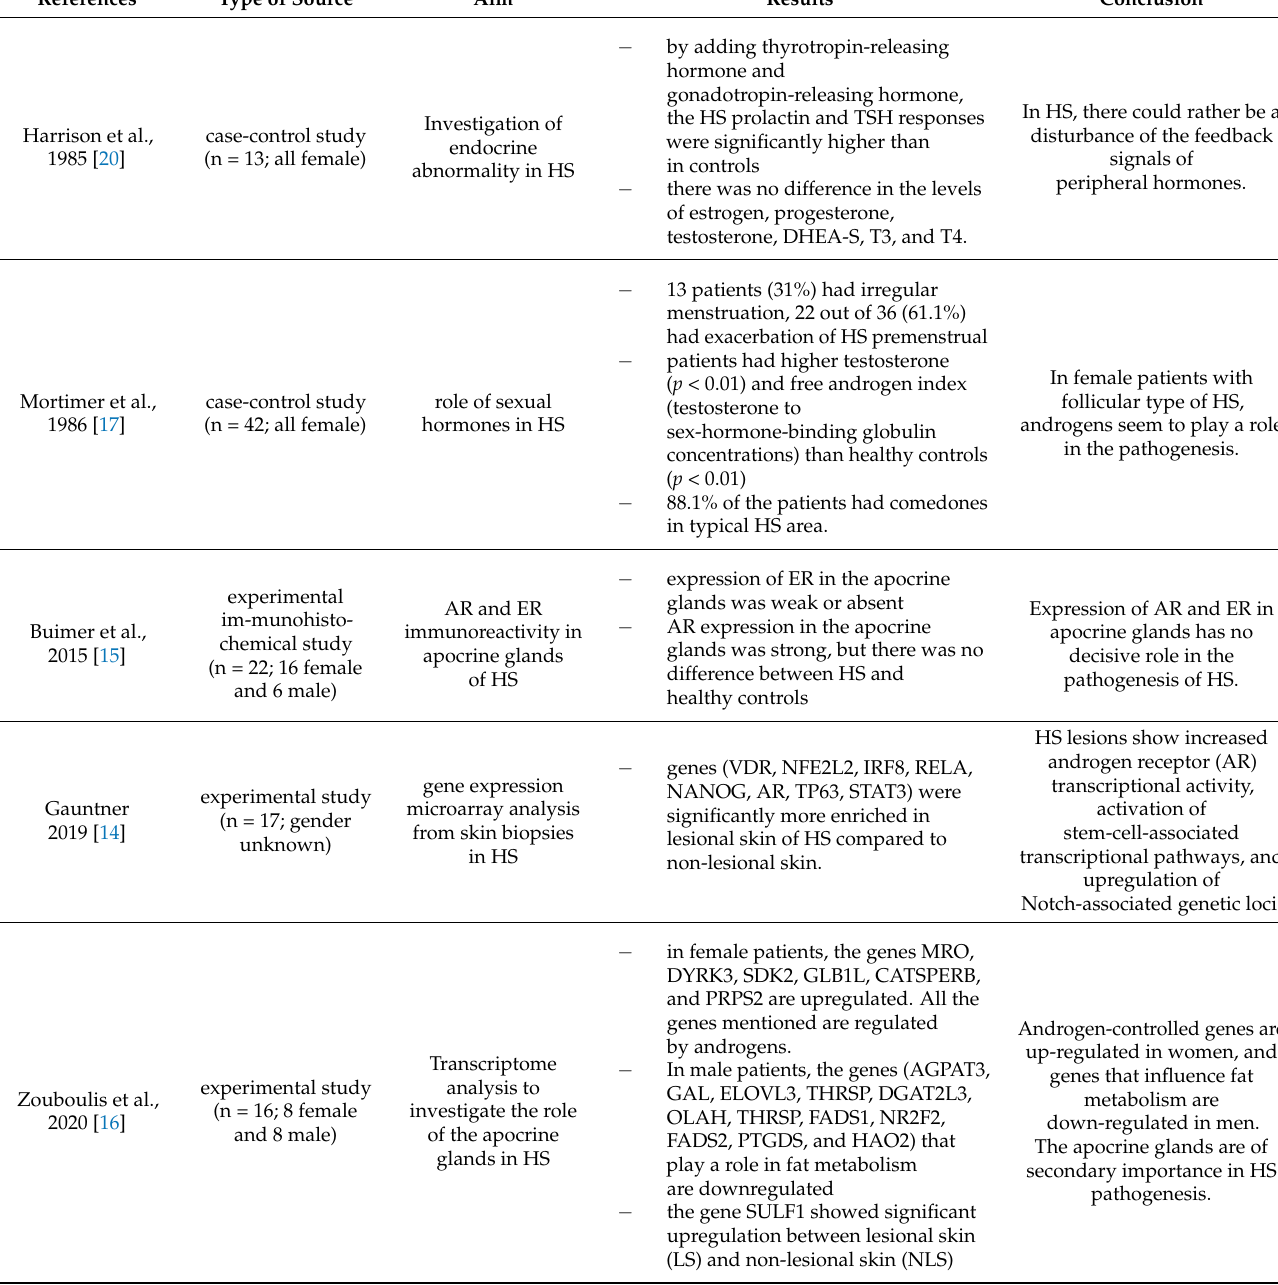
Table 2. Current findings about sexual hormones in